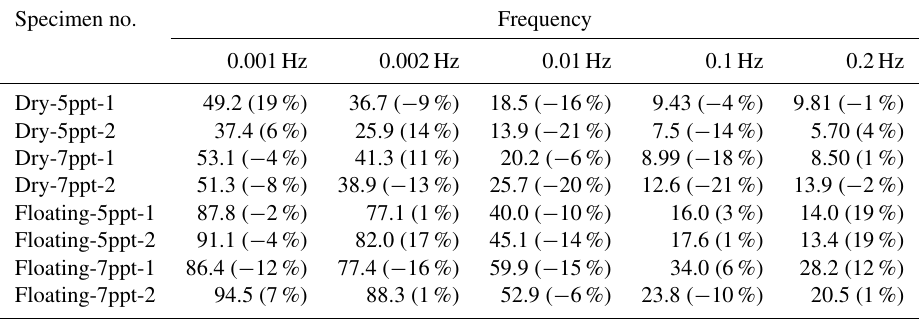
Table 6. Modeling results of the strain energy dissipation rate (%) per loading–unloading cycle (the values given in parentheses are error percentages of model predictions relative to experimental